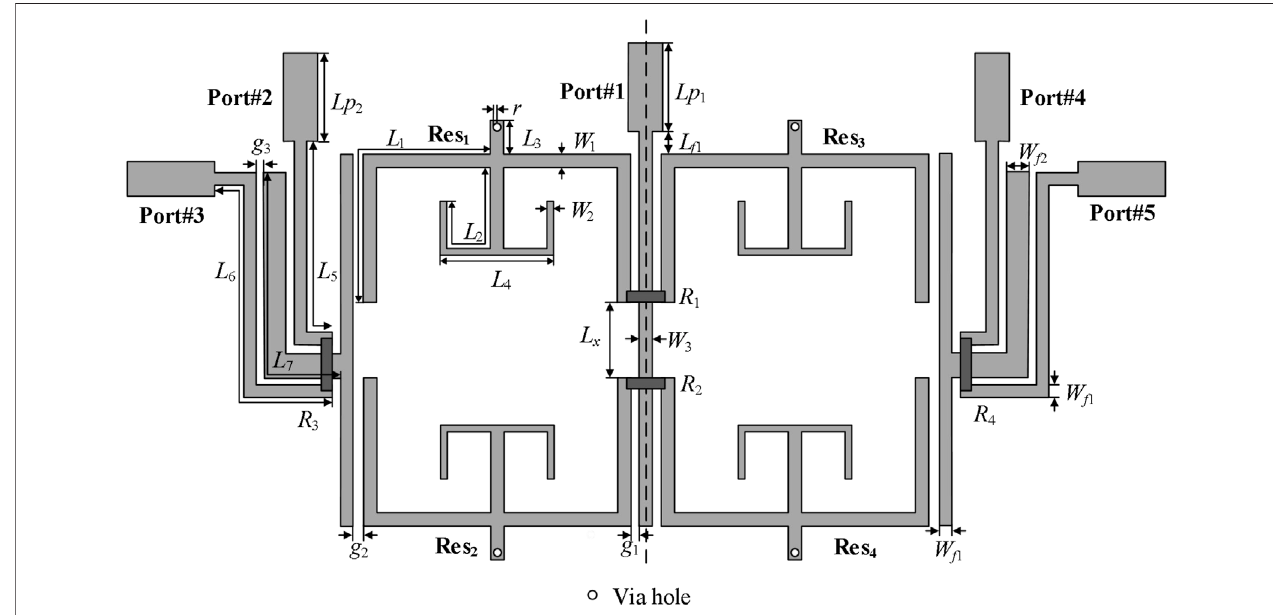
FIGURE 1 | Con fi guration of proposed four-way triple-band FPD.